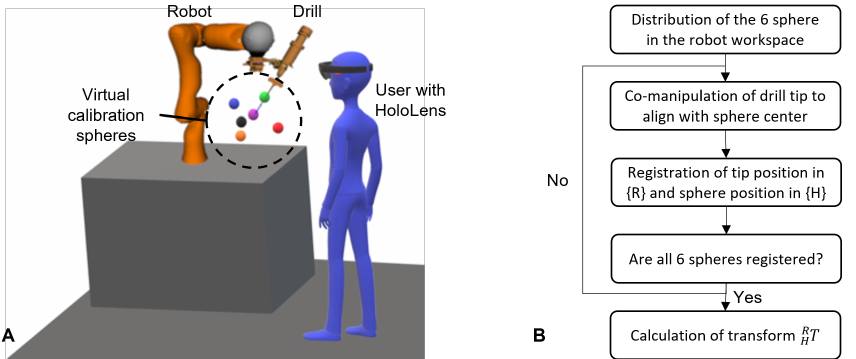
Figure 4. ( A ) The layout of the calibration procedure. The colored spheres are the AR calibration points seen by the user through the HoloLens. ( B ) The flowchart of the calibration